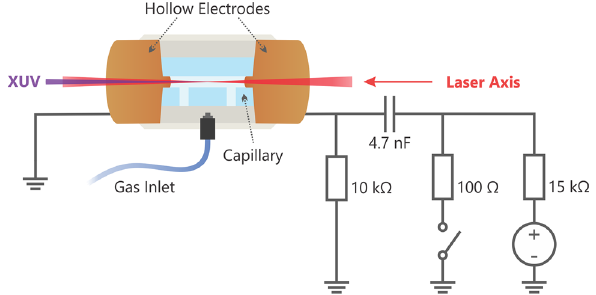
Figure 3. Schematics of the gas-filled capillary with two hollow copper electrodes connected to the RLC circuit driving the capillary discharge to generate the pre-ionized medium for